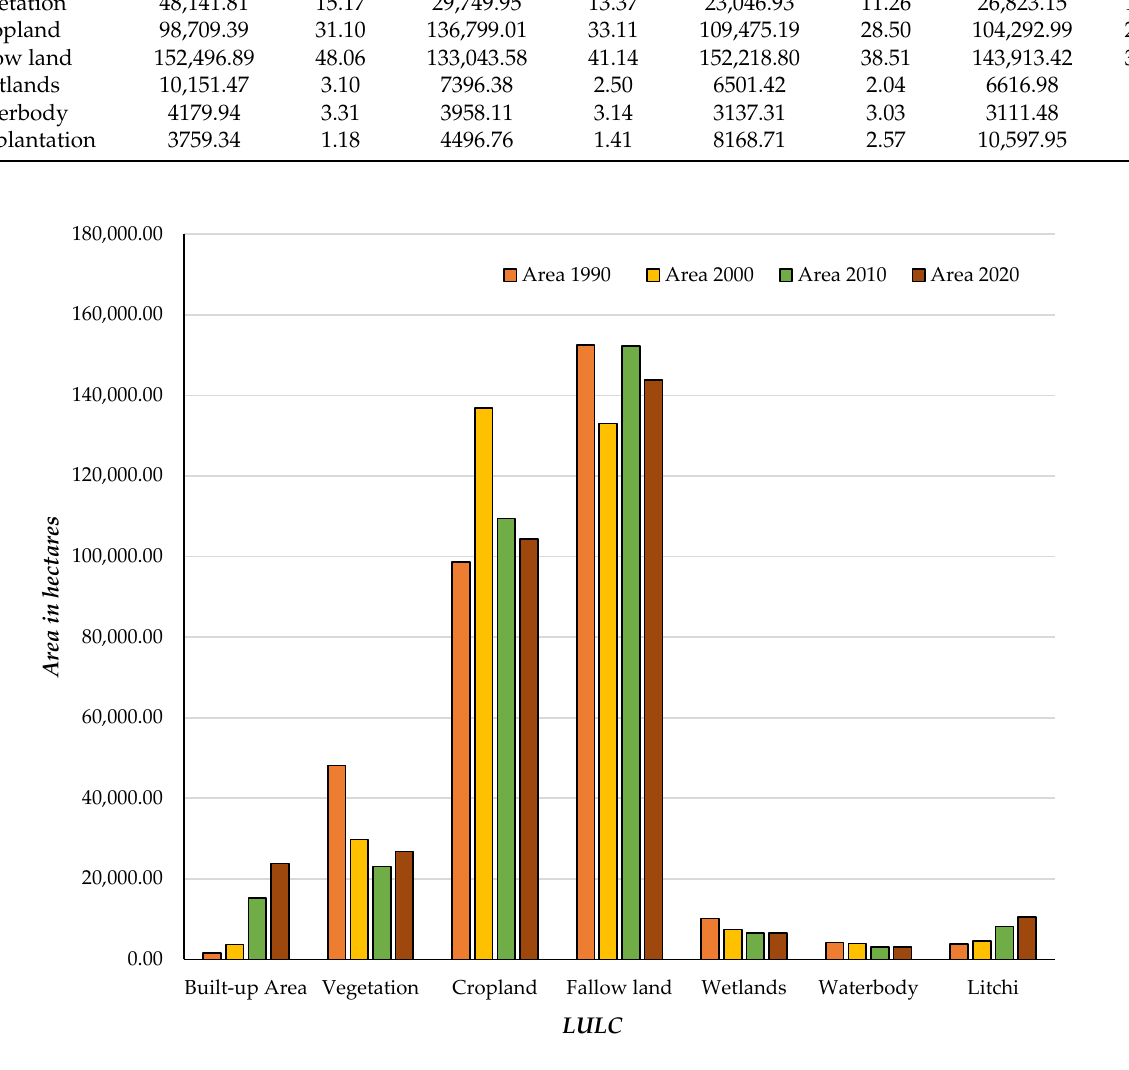
Figure 5. Comparative area estimates of different LULC classes from 1990–2020. Table 4. Percent change estimates in LULC during the period of 1990 to 2020.